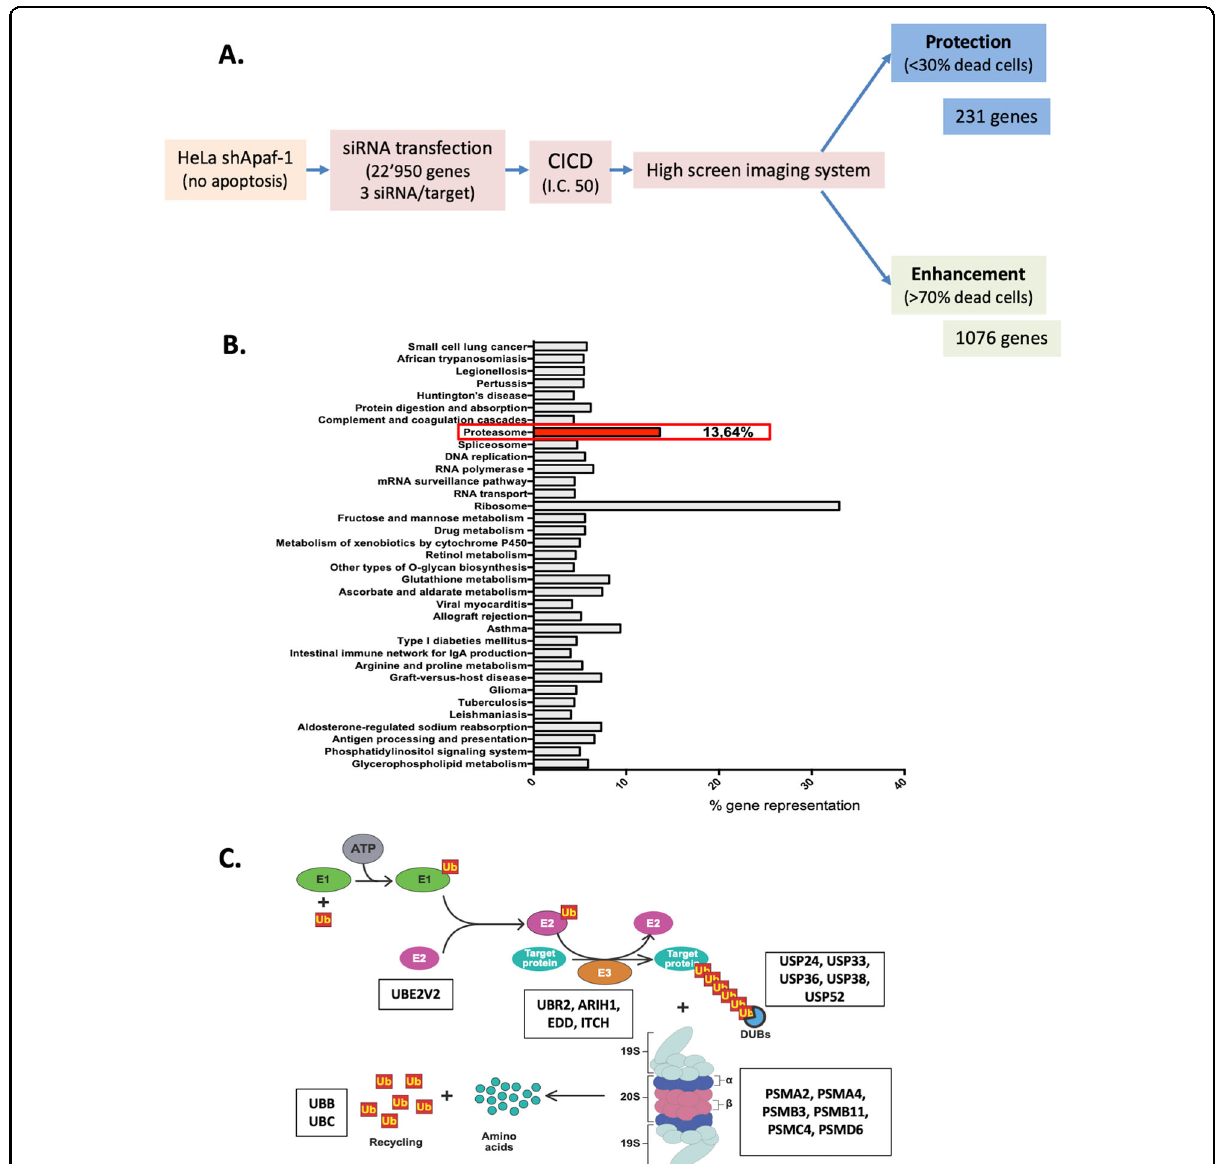
Fig. 2 Genome wide screening to identify CICD regulators. A summary of the protocol for the genome wide siRNA lethality screening on HeLa Apaf-1 KD cells and identi fi cation of CICD regulators. B Distribution of all the enriched pathways found for the genes in the hit list. Genes were grouped according to their participation in the indicated processes. KEGG Pathway database was used, altogether with a combination of several plug-ins in Cytoscape software and a set of appropriate statistical analysis. C Schematic representation of the Ubiquitin-Proteasome System (UPS). All the UPS genes identi fi ed as regulators in the CICD screening are indicated in